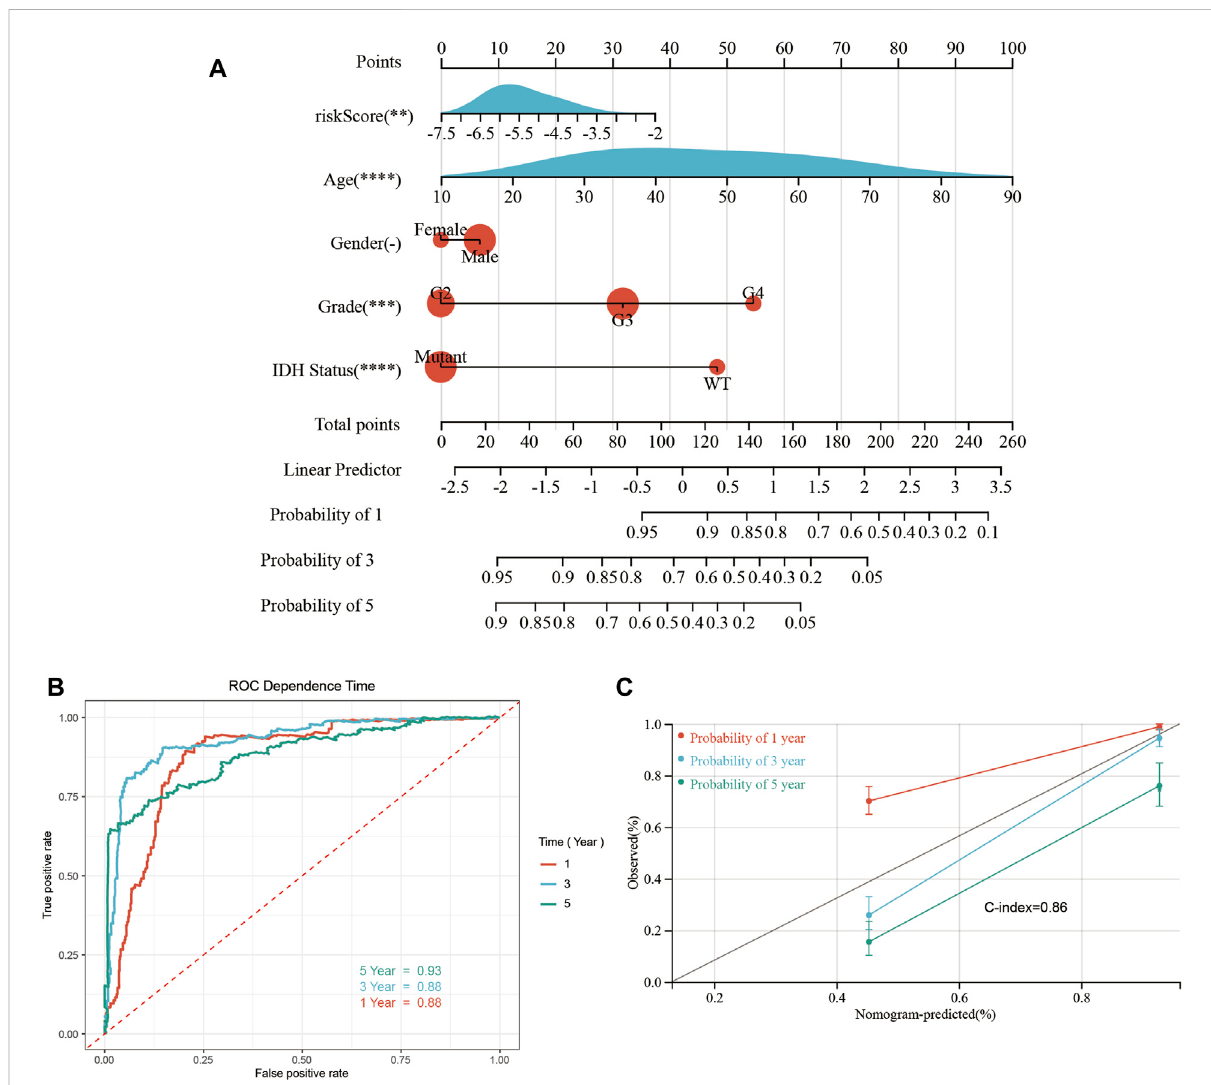
FIGURE 9 Construction and performance test of the nomogram. (A) Nomograms for predicting 1-, 3-, and 5-year OS in glioma patients. (B) Time- dependent ROC curves analysis was used to evaluate the OS of glioma patients at 1, 3, and 5 years. (C) The calibrationcurve of OS in glioma patients at 1-, 3-, and 5-year stages was evaluated through a nomogram (* p < 0.05, ** p < 0.01, *** p < 0.001, ns: p >